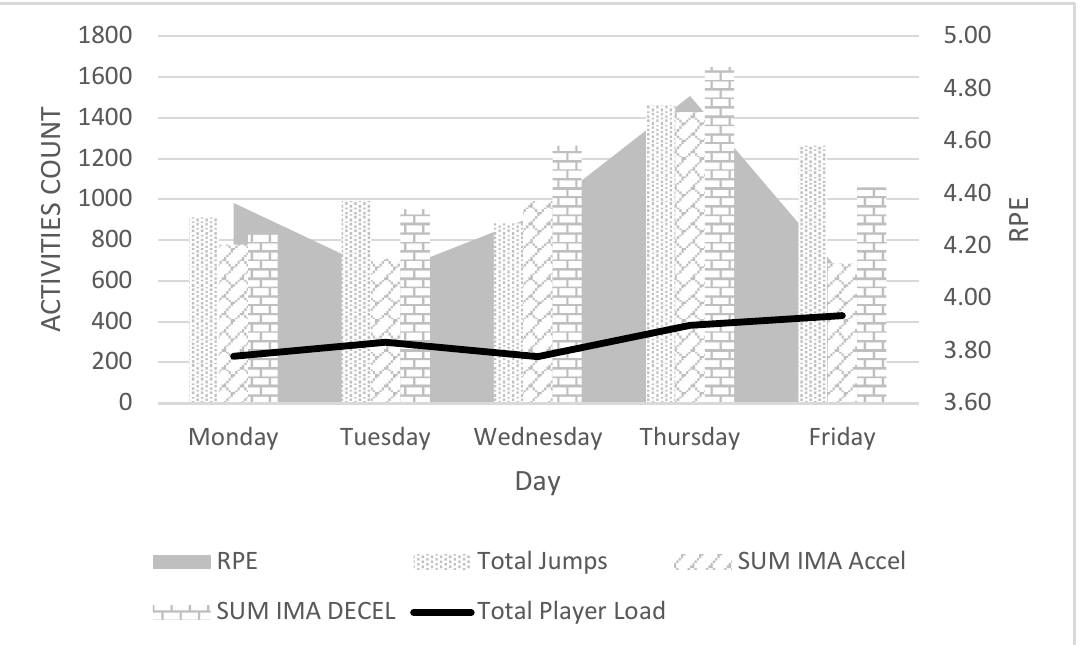
Figure 2. Correlations between s-RPE and ETL factors. Session Rating of Perceived Exertion (s-RPE), External Training Load (ETL), Inertial Movement Analysis Accel/Decel (IMA Accel/Decel).